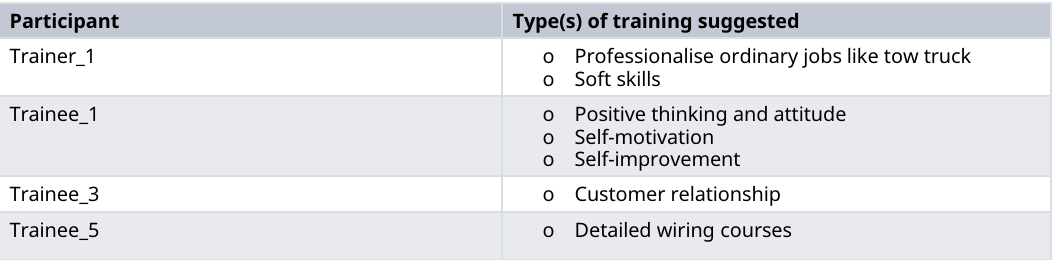
Table 4. Types of training wanted or needed by B40 youth.